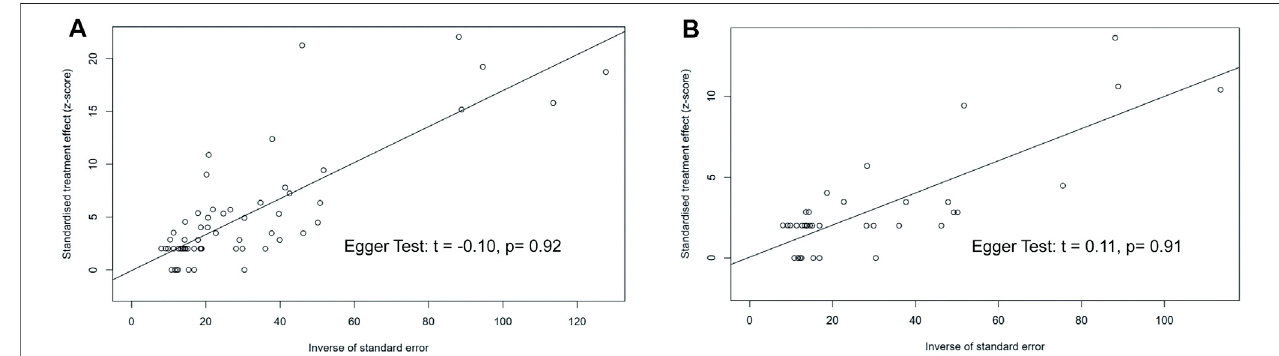
FIGURE 5 | Funnel plot and Egger test evaluating the publication bias of studies. The p -values of Egger test for all-grade and grade 3 or higher coronary disorder were 0.92 and 0.91, respectively, suggesting no signi fi cant publication